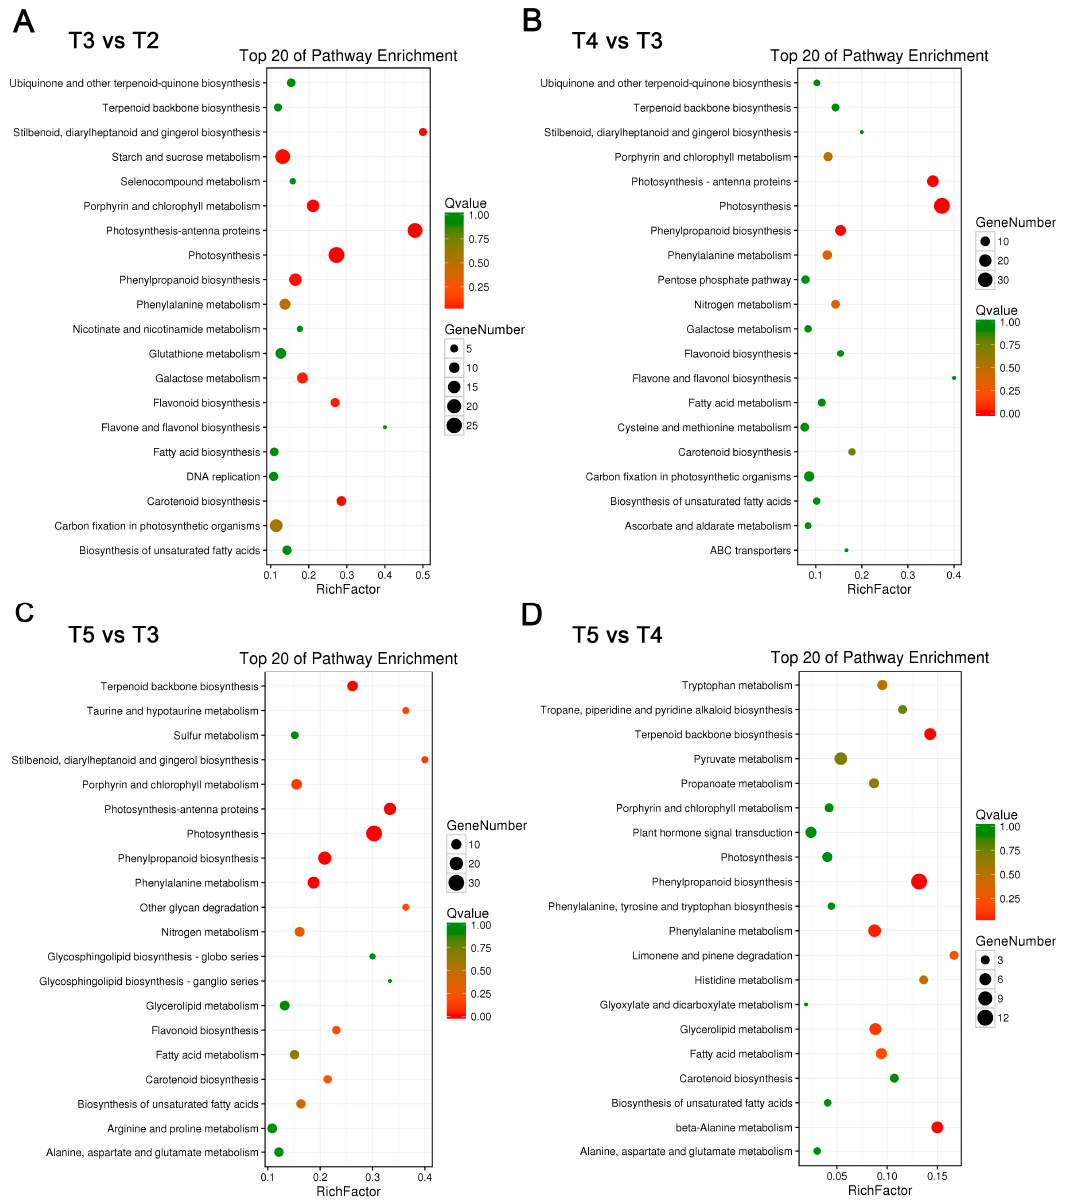
Figure 4. Enrichment of metabolic pathways at different tepal development and pigmentation stages. ( A – D ) Statistics of pathway enrichment in: T3 vs. T2 ( A ); T4 vs. T3 ( B ); T5 vs. T3 ( C ); and T5 vs. T4 ( D ) tepal transcriptome comparisons. The top 20 enriched pathways based on q-values in each comparison and the number of unigenes in each pathway are